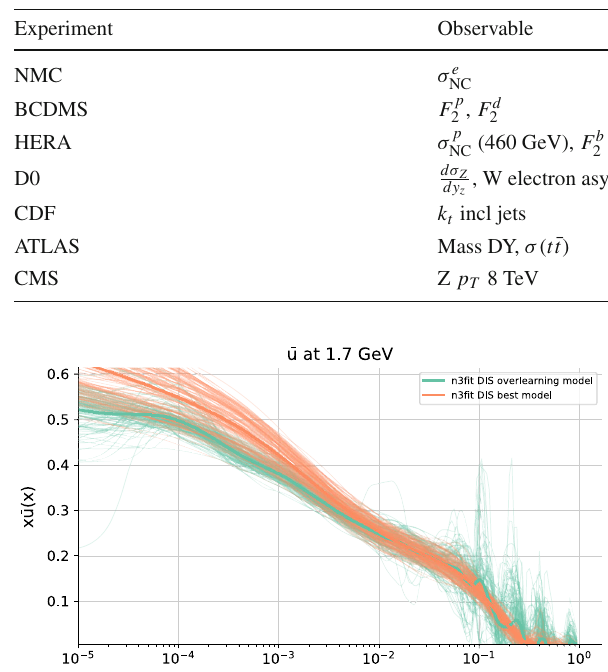
Table 3 List of datasets used for the testing procedure of the hyperpa- rameter scan. After each fit the generalization power of the network is tested on these sets and the iteration discarded if its χ 2 greatly differs from the validation and training χ 2 . This list is a subset of the datasets entering the fits for NNPDF 3.1 [4]